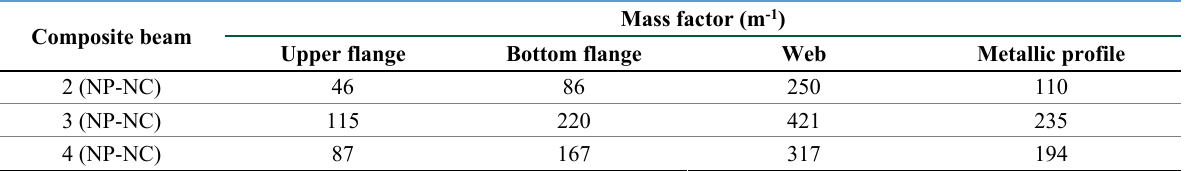
Table 4. Mass factor of each part and of the metallic profiles of the composite beams 2 (NP-NC), 3 (NP-NC) e 4 (NP-NC). Mass factor (m -1 ) Composite beam Upper flange Bottom flange Web Metallic profile 2 (NP-NC) 46 86 250 110 3 (NP-NC) 115 220 421 235 4 (NP-NC) 87 167 317